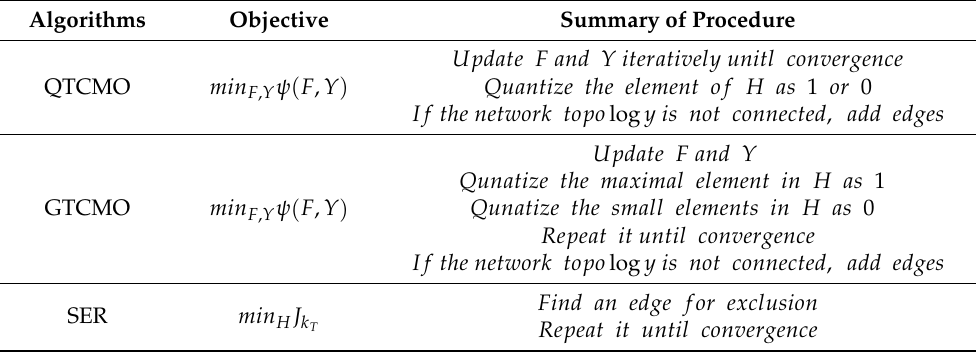
Table 2. The summary of the three proposed algorithms.